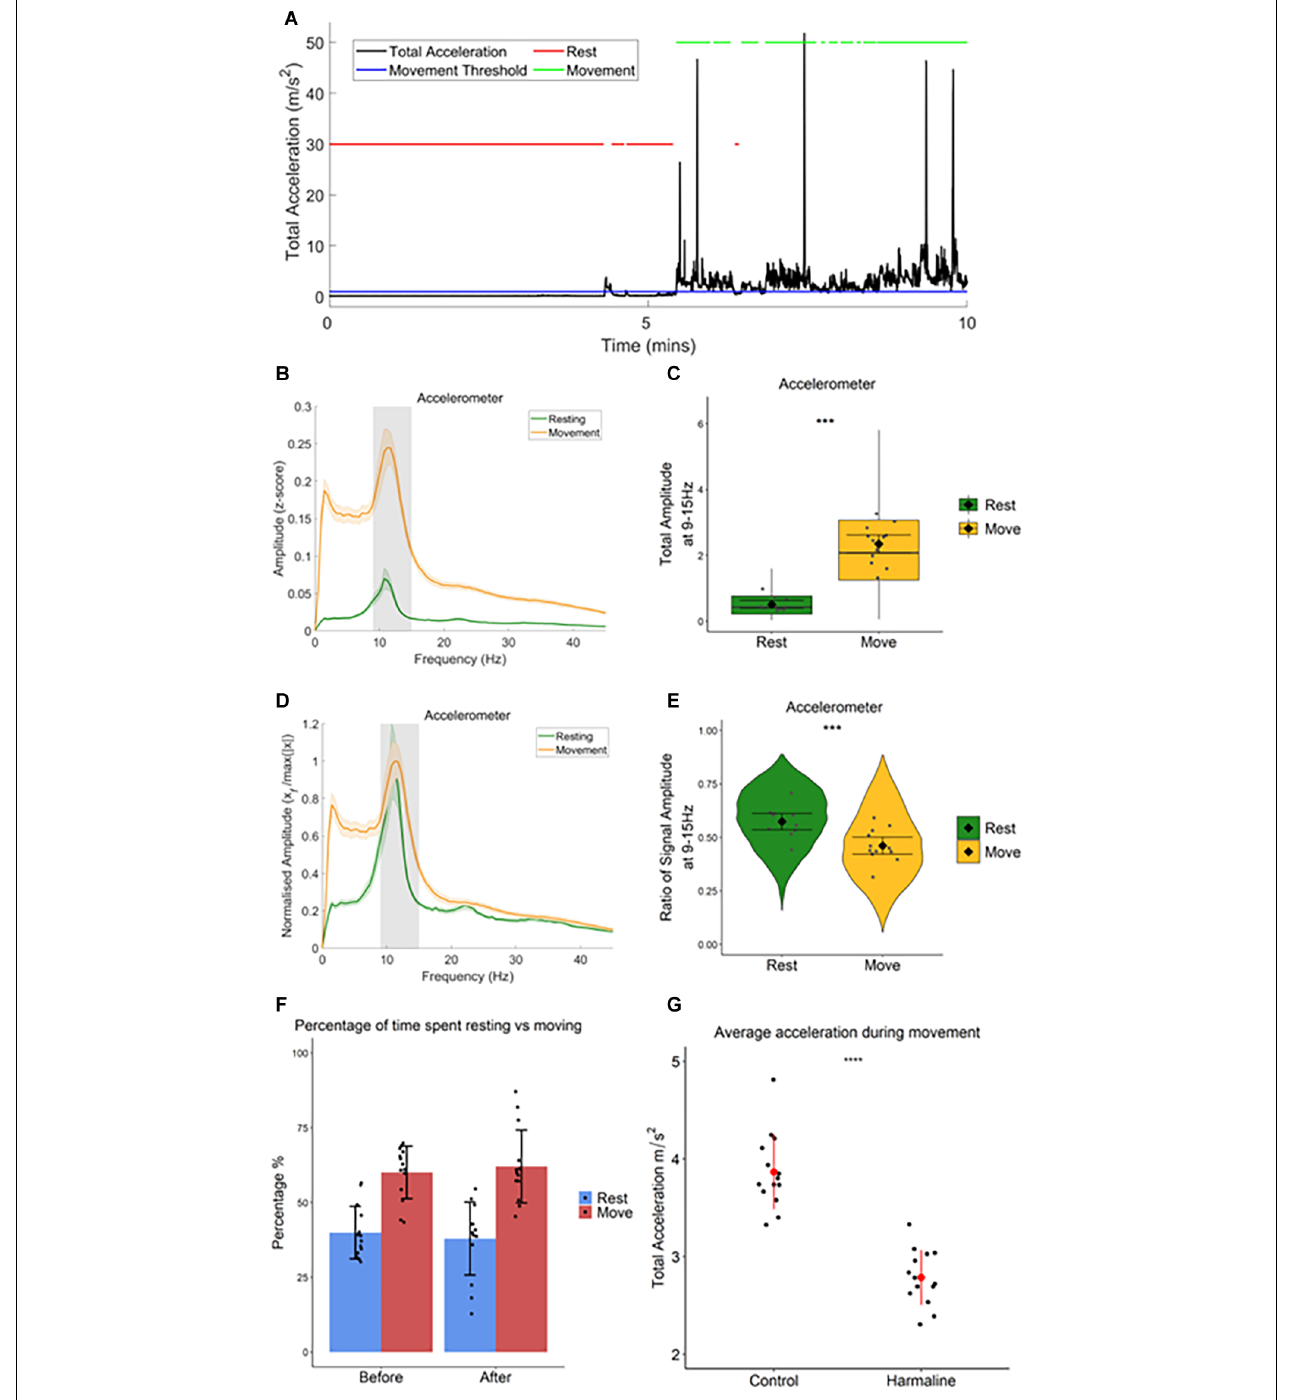
FIGURE 4 | Total amplitude of harmaline-induced tremor increases with movement. (A) Movement threshold (1 ms − 2 ; blue horizontal line) applied to total acceleration data (black) to distinguish periods of rest and movement. Red lines demonstrate time points categorised as “rest”, and green lines demonstrate time points categorised as “movement”. (B) Total ( ± SE) and (D) relative ( ± SE) amplitude accelerometer spectrum ( n = 12 rats) during rest and movement. The solid line represents the mean, and the coloured shaded areas represent SE. The grey area represents the tremor frequency. (C) Total accelerometer amplitude and (E) ratio of accelerometer amplitude at the tremor peak, across all epochs (pooled across rats). Individual grey points represent the mean per rat. Fixed effects parameter estimates ( ± CI) representing predicted mean estimates are shown by (cid:7) and corresponding error bars. ∗∗∗ indicates p < 0.001. (F) Percentage of time spent resting and moving during baseline (before) and harmaline conditions. Each dot represents one rat. Error bars represent ± SD. (G) Average total acceleration during movement before (control) and after harmaline treatment. Each dot represents one rat. Error bars represent ± SD. ∗∗∗ indicates p < 0.001.